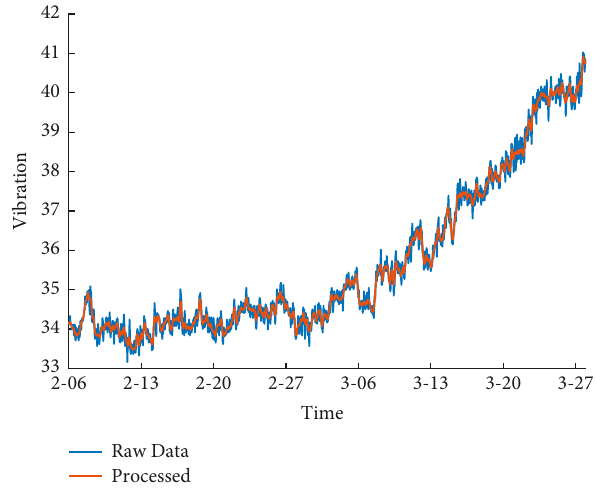
Figure 2: Raw and denoised